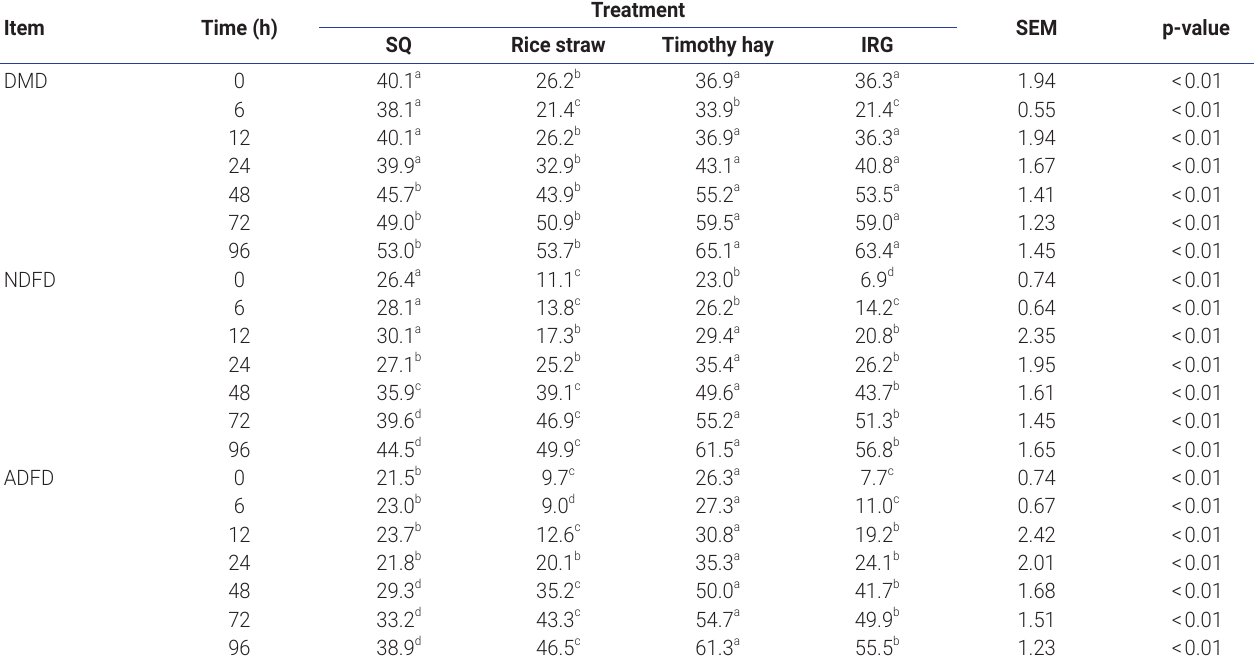
Table 6. In situ ruminal degradability of four roughage types (% dry matter